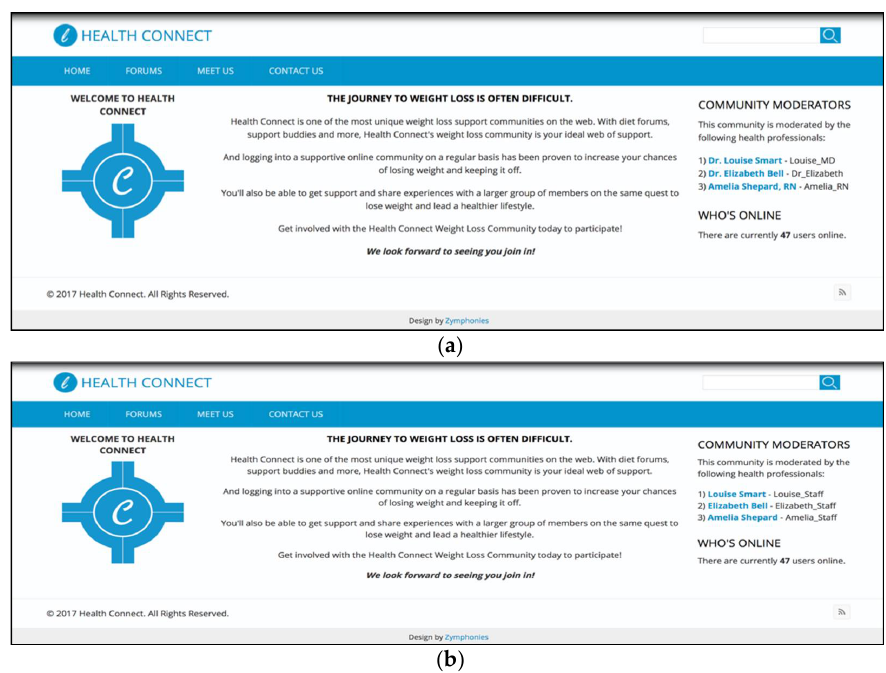
Figure 1. Health Connect stimuli: ( a ) Health Connect with credentialed moderators; ( b ) Health Connect with staff moderators .